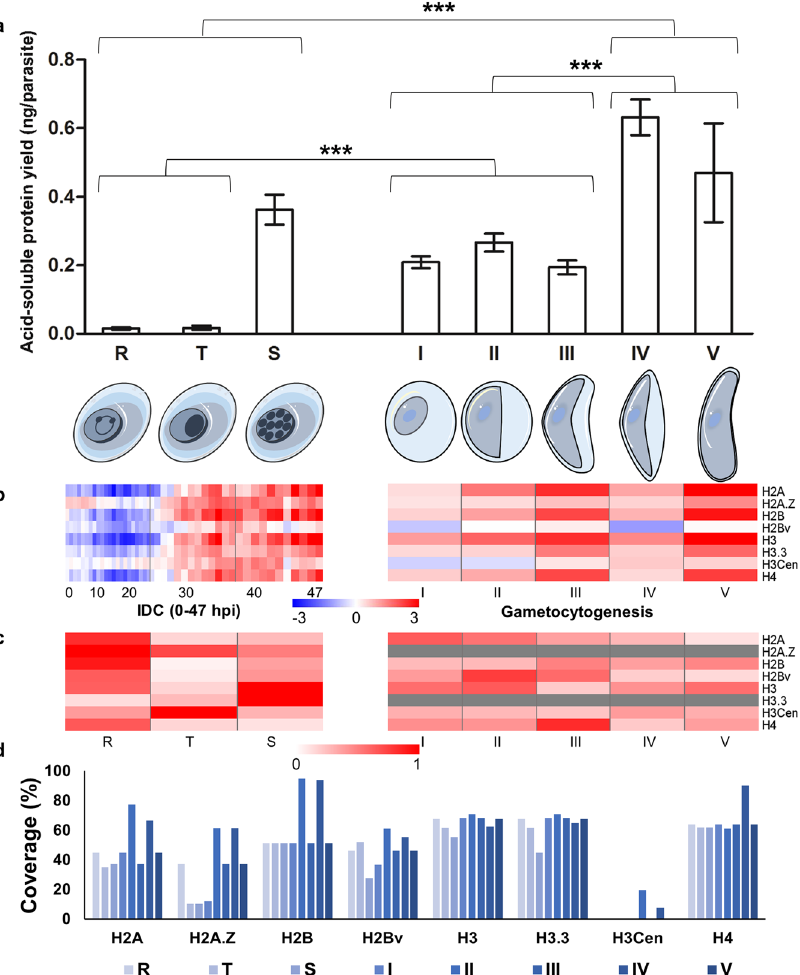
Figure 1. P. falciparum histone prevalence during development. Eight P. falciparum life cycle stages, including rings, trophozoites, schizonts and stage I, II, III, IV and V gametocytes were isolated and the histones were acid-extracted. ( a ) The yield (ng/parasite) of histone-enriched, acid-soluble protein fractions per isolated parasite for each developmental stage was determined (two-tailed equal variance t-test, *** P < 0.001, n = 3 ± SEM). Histones refer to the isolated acid-soluble protein fraction containing the histone proteins and not to pure isolated histones. ( b ) Expression of the eight P. falciparum histones over asexual and sexual life cycle development. The expression values (log 2 , Cy5/Cy3) of the core and variant histone transcripts are shown over the 48 h IDC (hpi) and throughout the duration of gametocytogenesis (days). ( c ) Protein abundance of the eight P. falciparum histones over asexual and sexual life cycle development. The relative abundance (normalised %) of the core and variant histone proteins are shown over the IDC and gametocytogenesis. The relative abundance data for H2A.Z and H3.3 was not available (indicated by grey bar). ( d ) Histone sequence coverage (%) for the eight P. falciparum histones are shown for each life cycle stage. H3Cen was only identified in stage II and IV